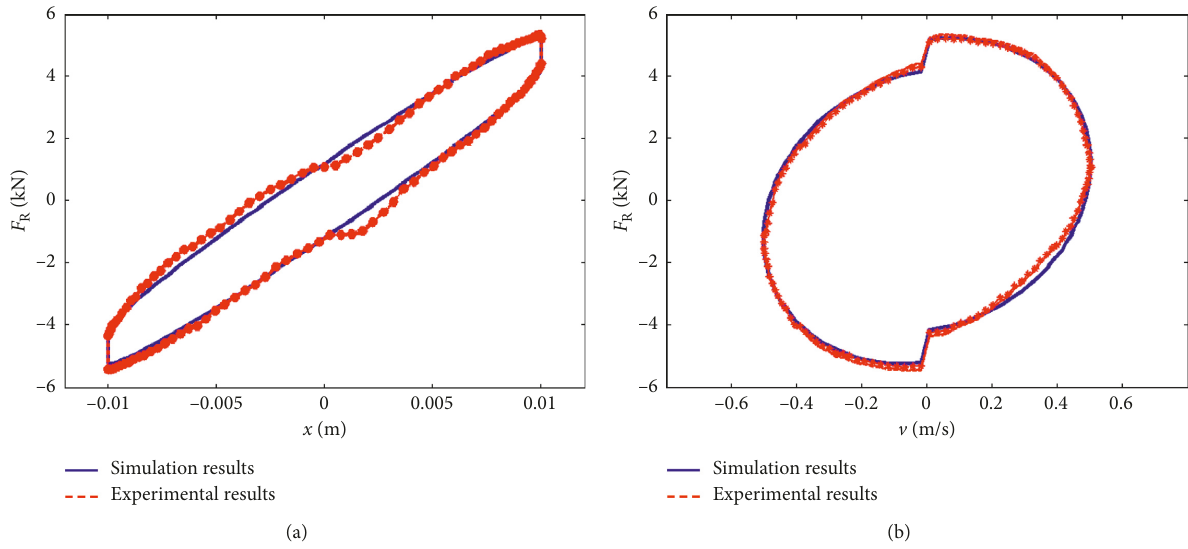
Figure 7: Comparison diagram of the model simulation and experimental results at a frequency of 8Hz.